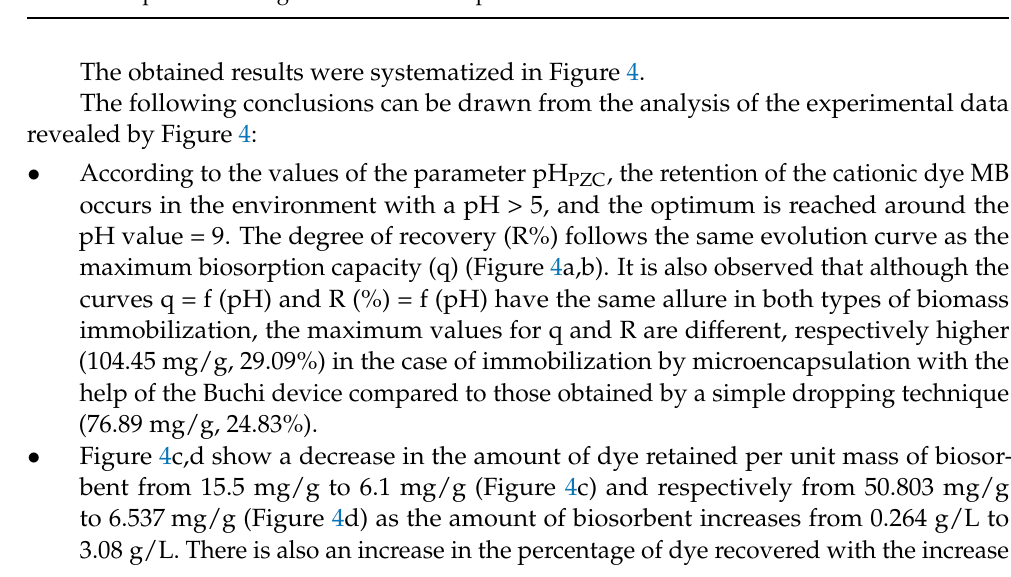
Table 1. Physical–chemical parameters that influence the biosorption of methylene blue dye onto microbial biosorbent. Parameters Studied Limits of Variation 2–11